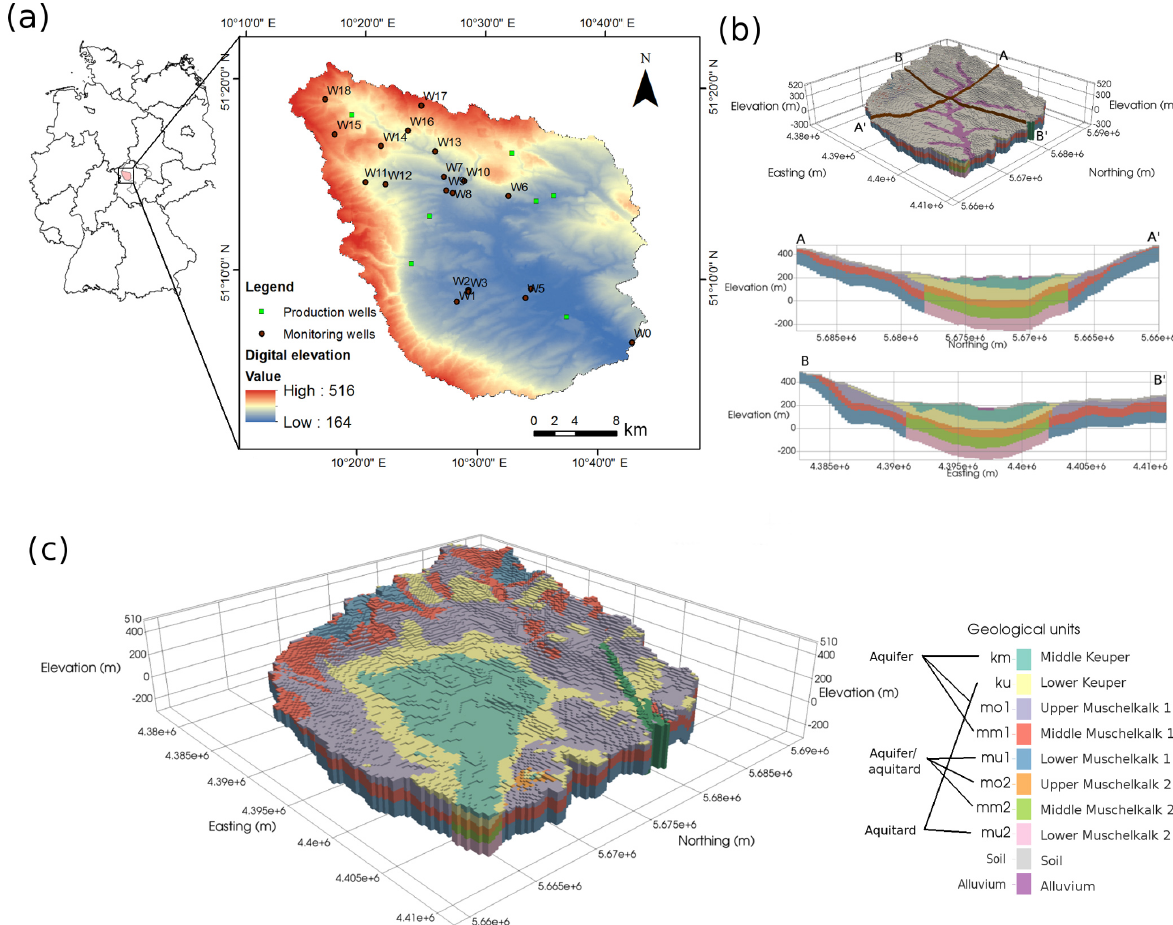
Figure 1. The Nägelstedt catchment used as the test catchment for this study (Jing et al., 2018a). (a) An overview of the Nägelstedt catchment and the locations of the monitoring wells used in this study. (b) 3-D view highlighting the arrangement of alluvium and soil and cross-sectional view of the study area. (c) 3-D view highlighting the zonation of the sedimentary aquifer–aquitard system. Note that the Muschelkalk layers (mo, mm, and mu) are divided into more permeable subunits (mo1, mm1, and mu1) and less permeable subunits (mo2, mm2, and